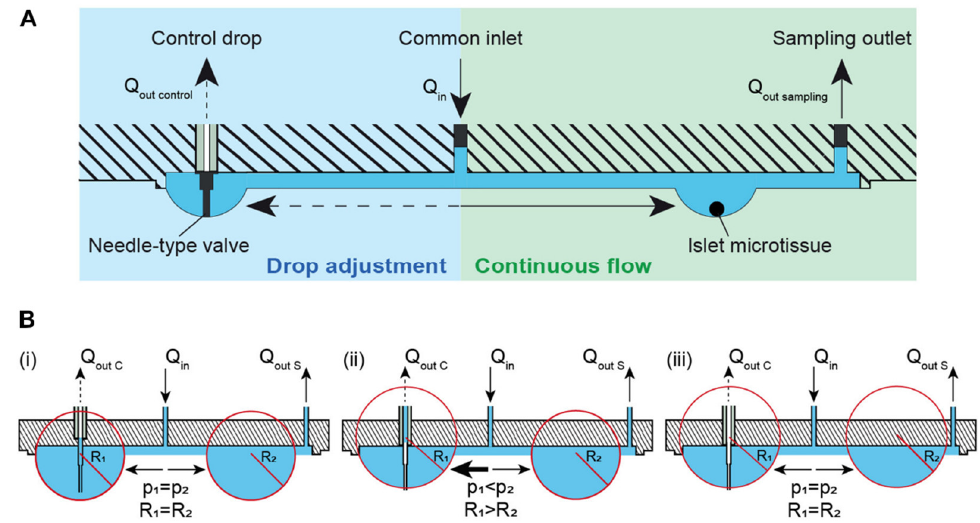
Figure 10. Theory and concept of the automatic hanging-drop-size adjustment in the microfluidic chip. ( A ) The inflow ( Q in ) was split into two flows, one toward the islet drops (right) and the other toward the control drop (left). There was a continuous flow of liquid from the inlet toward the islet drops due to active sampling from the sampling outlets at the rate of Q out sampling . An irregular flow was observed from the inlet toward the control drop due to the alternating withdrawal of liquid and air from the needle-type valve at a rate of Q out control . ( B ) Self-regulation of drop heights between interconnected hanging drops. Liquid was constantly added into the system at a rate of Q in and withdrawn through the sampling outlet at a rate of Q out S and through a needle-type valve at a rate of Q out C . (i) Two hanging drops in equilibrium with identical Laplace radius and pressure. The inflow was evenly distributed to the two drops. As long as the tip of the needle-type valve was immersed in the drop, liquid removal through the valve occurred. Consequently, (ii) the size and the Laplace pressure of the two drops became different with drop radius and pressure being inversely correlated. Due to the pressure difference, there was an increased flow toward the control drop (left) with the lower pressure. As soon as the tip of the needle-type valve was exposed to air, only air was withdrawn. The control drop remained stable at the height defined by the valve needle length. (iii) In the next step, the two drops reached equal Laplace radius and pressure through equilibration through the liquid phase. The system was now stable, and the drop height in control and tissue drop was maintained constant. Reproduced from Wu Jin et al. [10] (CC BY 4.0).